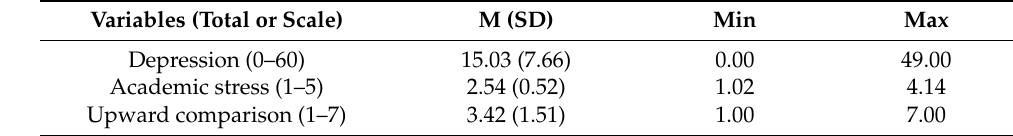
Table 2. Depression, Academic Stress, and Upward Comparison ( n =